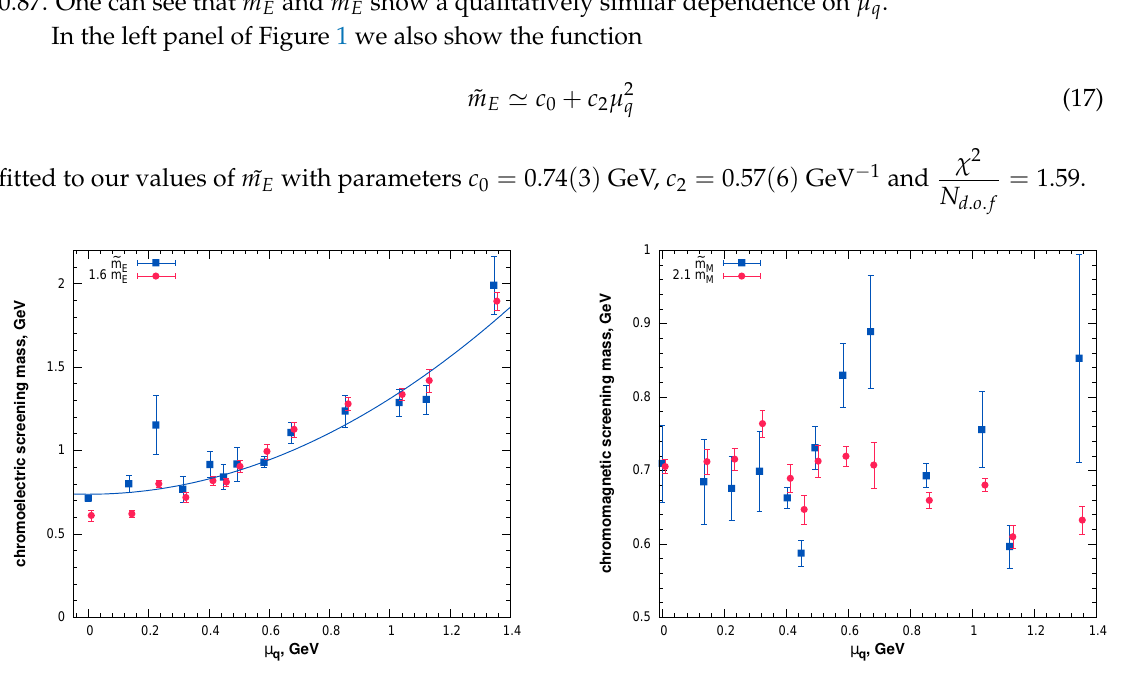
Figure 1. Chromoelectric ( left ) and chromomagnetic ( right ) Linde and proper screening masses as functions of µ q . The Linde mass m E is obtained from the propagators normalized at 6 GeV; to compare its dependence on µ q with that of ˜ m E , we show 1.6 m E for the chromoelectric mass and 2.1 m M for the chromomagnetic